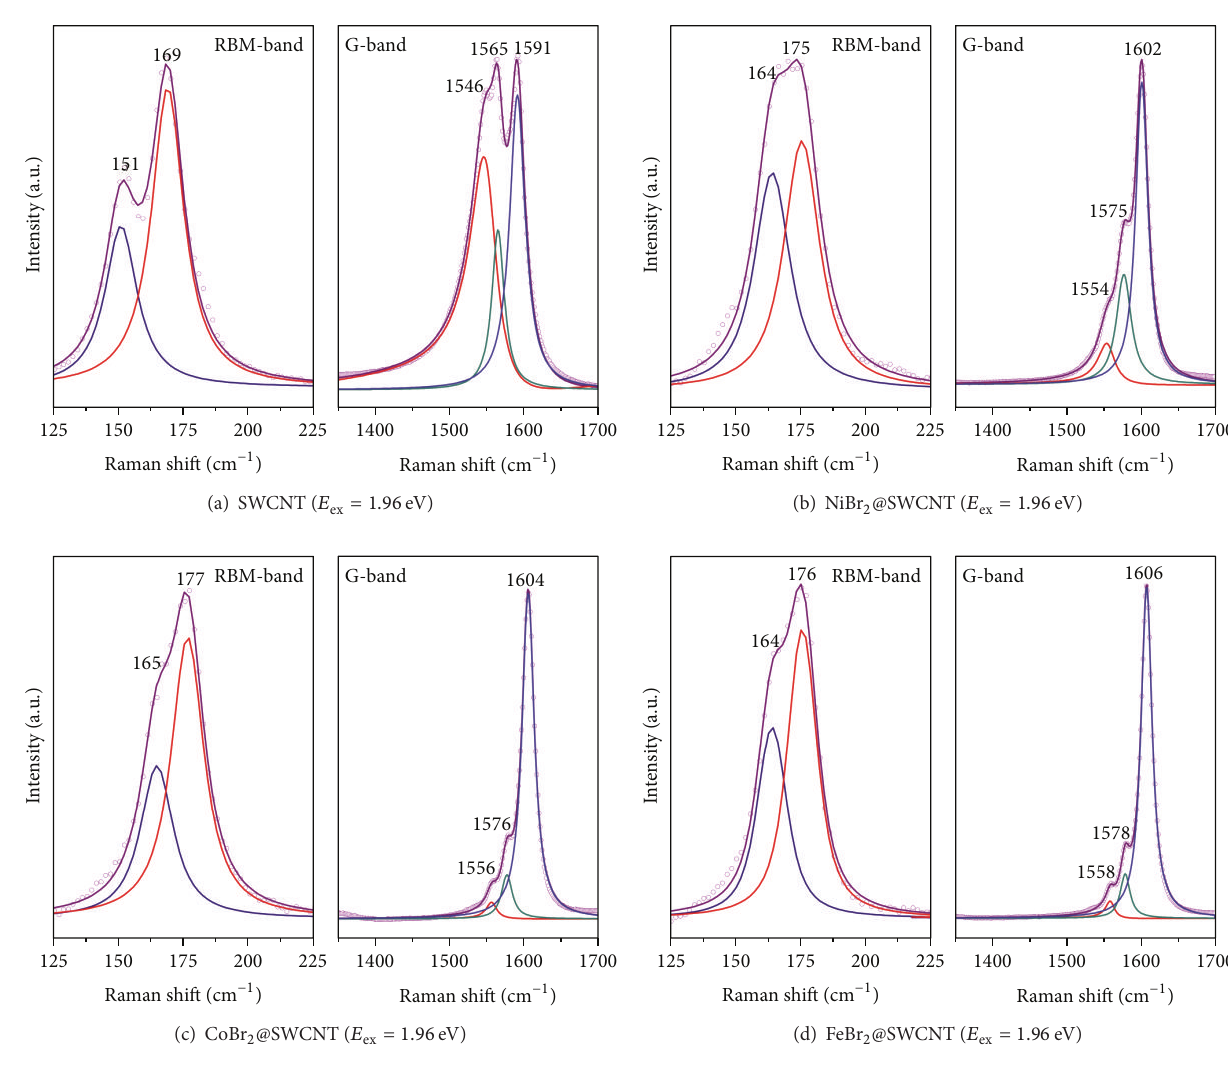
Figure 4: The fitting of the RBM- and G-bands of the Raman spectra of the pristine SWCNTs (a), NiBr 2 @SWCNT (b), CoBr 2 @SWCNT (c), andFeBr 2 @SWCNT(d)samplesacquiredatalaserenergyof1.96 eV.TheRBM-bandsincludetwocomponents,whichbelongtothenanotubes of different diameters. The G-bands include one component of metallic SWCNTs (G − at the lowest frequencies) and two components of at lower and G + at higher semiconducting SWCNTs (G + TO LO